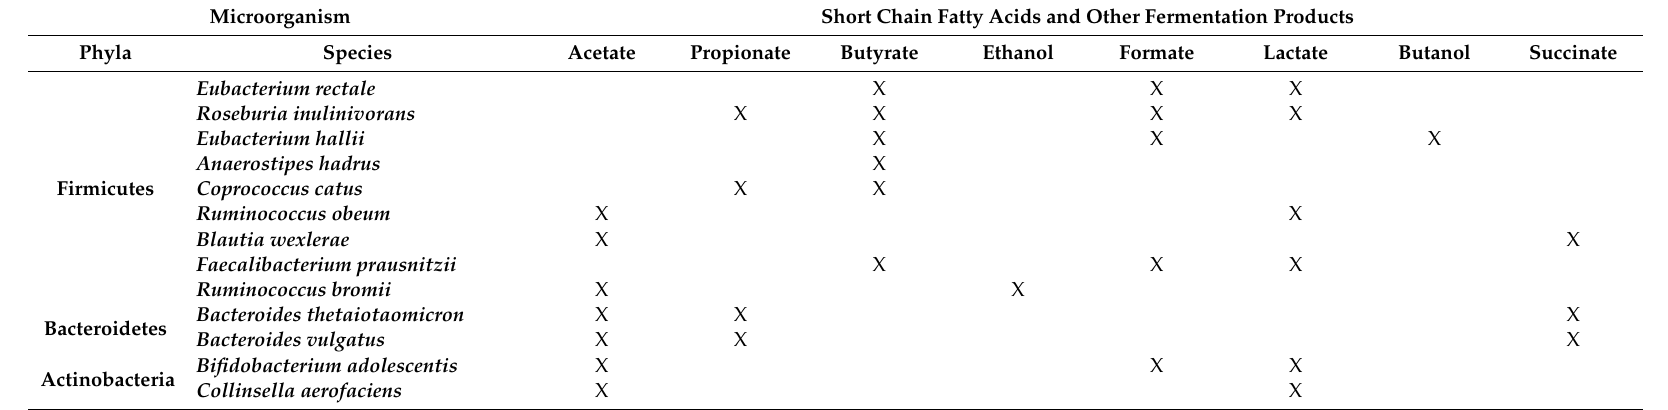
Table 2. Microorganisms that produce short chain fatty acids and other fermentation